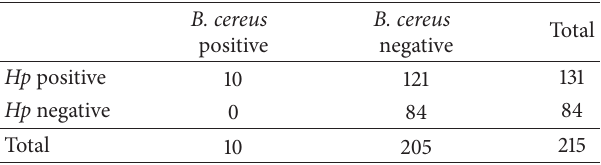
Table 8: Prevalence of Acinetobacter baumannii according to ethnic group.